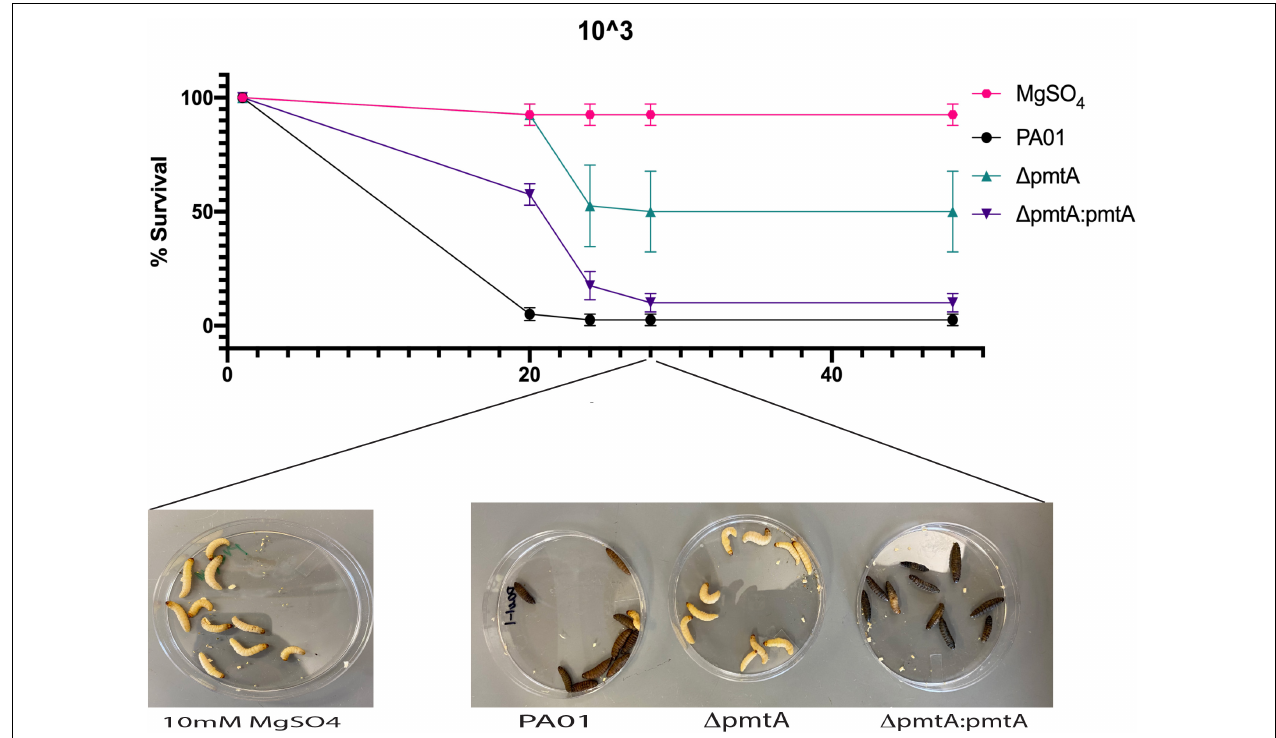
FIGURE 8 | Wild-type PAO1 is more lethal than the (cid:49) pmtA mutant in a G. mellonella model. G. mellonella were injected with 5 µ L of 10 3 /mL of either P. aeruginosa wild-type, (cid:49) pmtA and (cid:49) pmtA : pmtA PAO1 strains or 10 mM of MgSO 4 (control). G. mellonella survival was observed for 48 h for all four groups, and percent survival was calculated. (cid:49) pmtA had a higher survival percentage than PAO1 and (cid:49) pmtA : pmtA. The data are presented as the mean and standard deviation of the mean of three independent experiments ( n = 10/group).